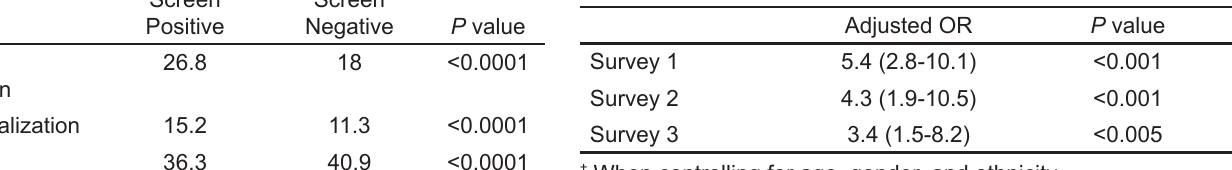
Table 5. Adjusted odds of meeting criteria for burnout among respondents who screen positive for depression †